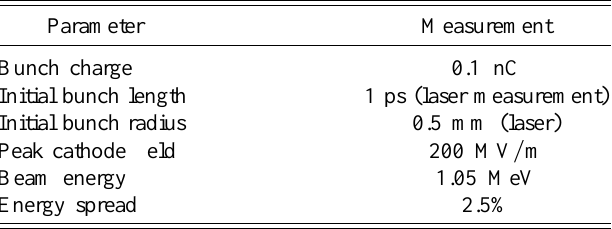
TABLE I. Beam measurement results from the original experiment.